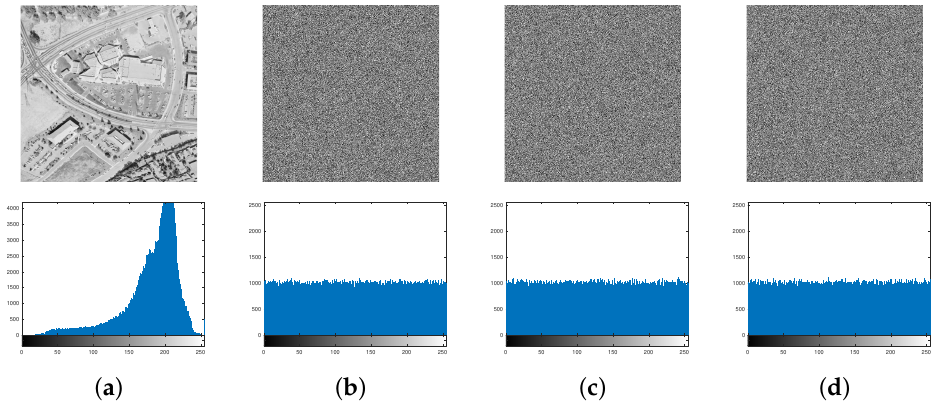
Figure 9. Key sensitivity test results for the encryption process: ( a ) 5.2.09; ( b ) cipher image ˜ C ( 1 ) obtained with K ( 1 ) ; ( c ) cipher image ˜ C ( 2 ) obtained with K ( 2 ) ; ( d ) Difference image obtained by ( ˜ C ( 2 ) − ˜ C ( 1 ) ) mod 256.